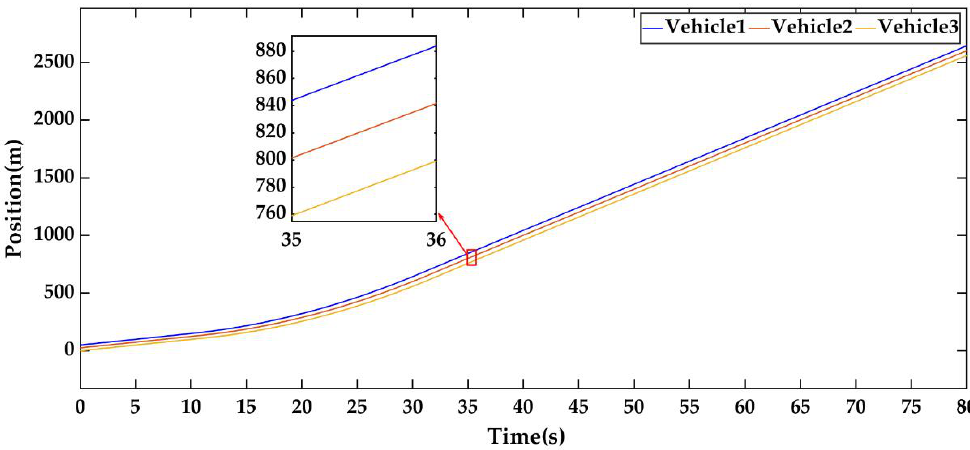
Figure 14. The positions of the following vehicle under the improved MPC strategy in Scenario 1.